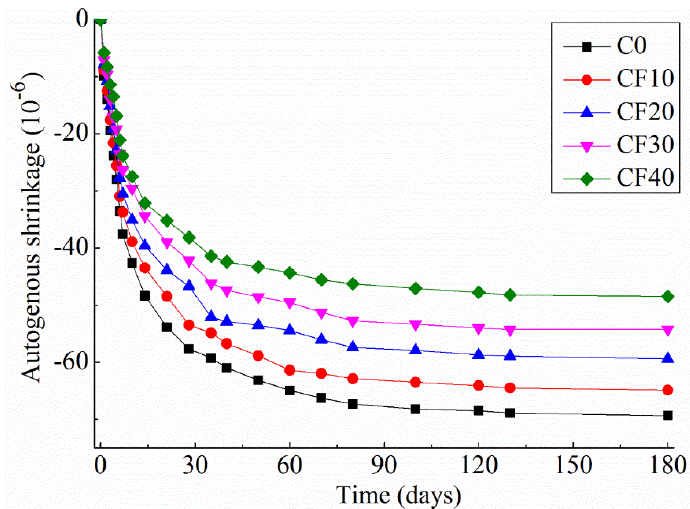
Figure 5. Autogenous shrinkage of face slab concretes with various fly ash dosages.